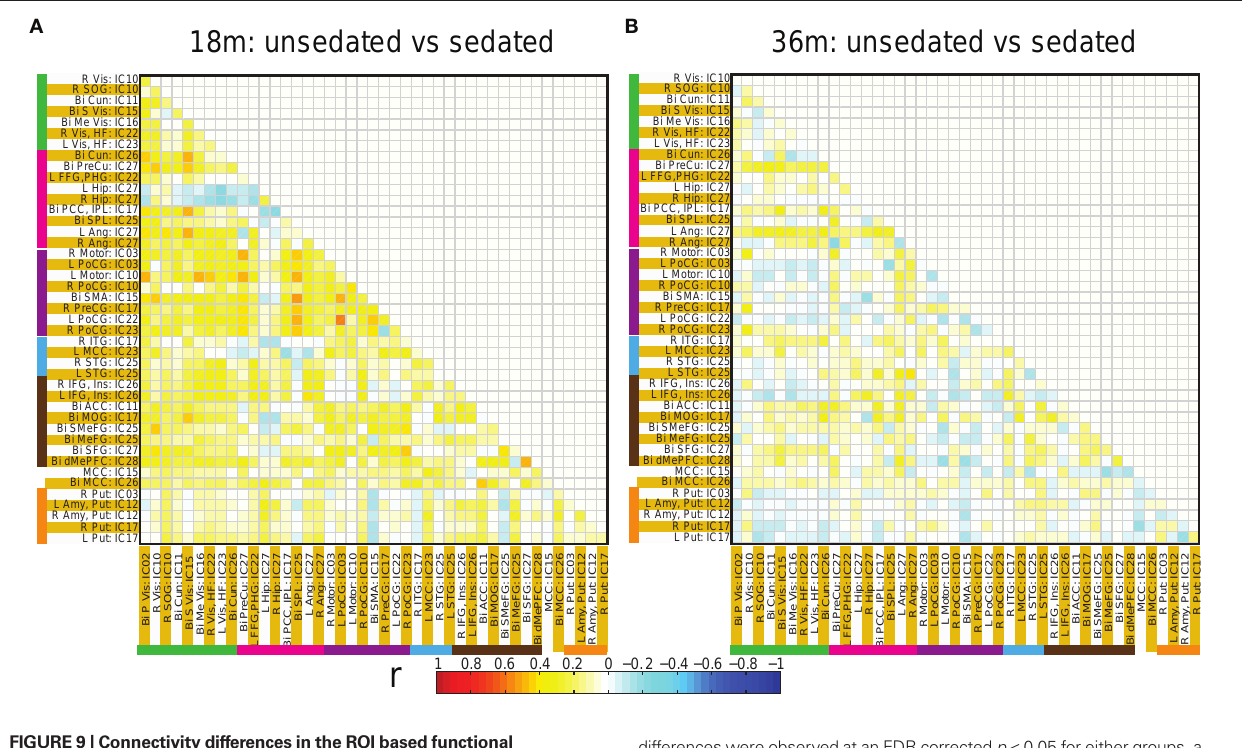
Figure 9 | Connectivity differences in the roi based functional connectivity between pre-term unsedated and sedated children for the 18 month (A) and the 36 month (B) groups. Although no significant